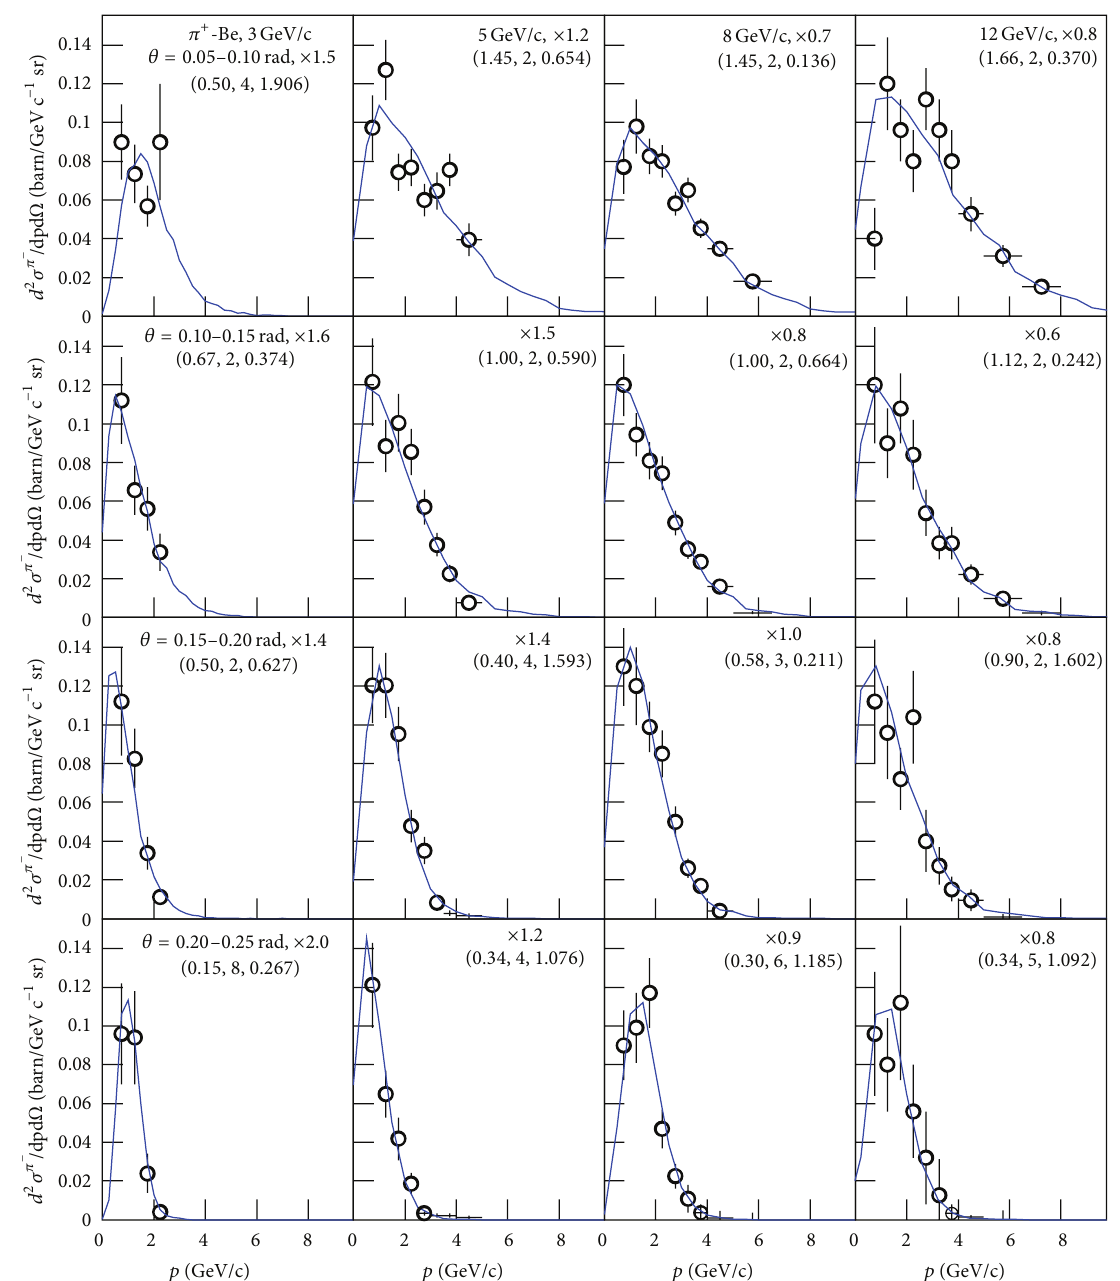
Figure 4: The same as Figure 1, but showing the results for 𝜋 − production cross sections in 𝜋 + - Be